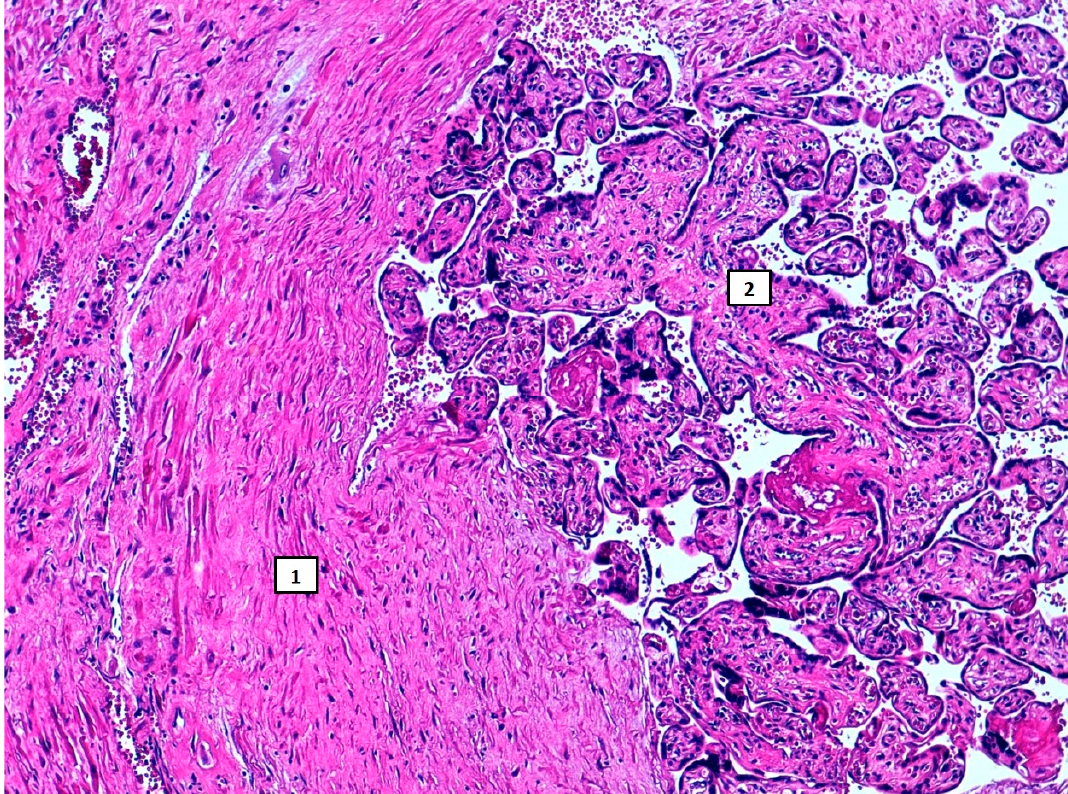
Figure 5. 10× magnification hematoxylin/eosin slide. (1) Myometrium. (2) Chorionic villi. Villi lay directly on the myometrium, without intermediate chorionic plaque, a placenta accreta feature.